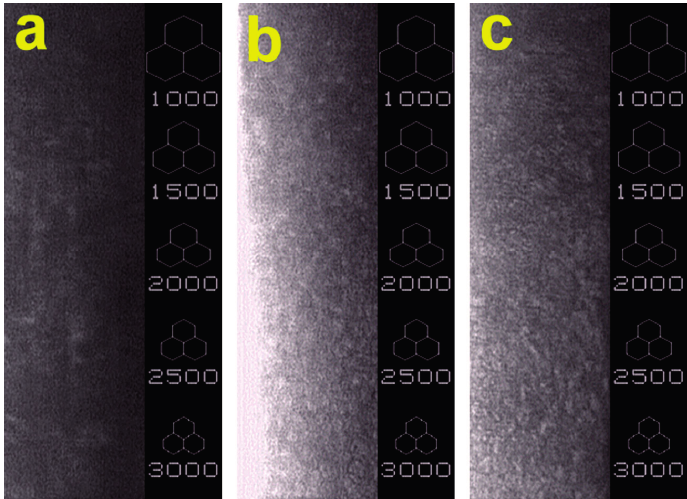
Figure 8. Representative specular microscopic images of rabbit eyes four weeks after surgical treatment of corneal endothelial dysfunction. ( a ) Control group: cornea denuded of endothelium; ( b ) HFT group: endothelial scrape-wounded cornea implanted with HFT carriers and bioengineered CEC sheet; and ( c ) LFT group: endothelial scrape-wounded cornea implanted with LFT carriers and bioengineered CEC